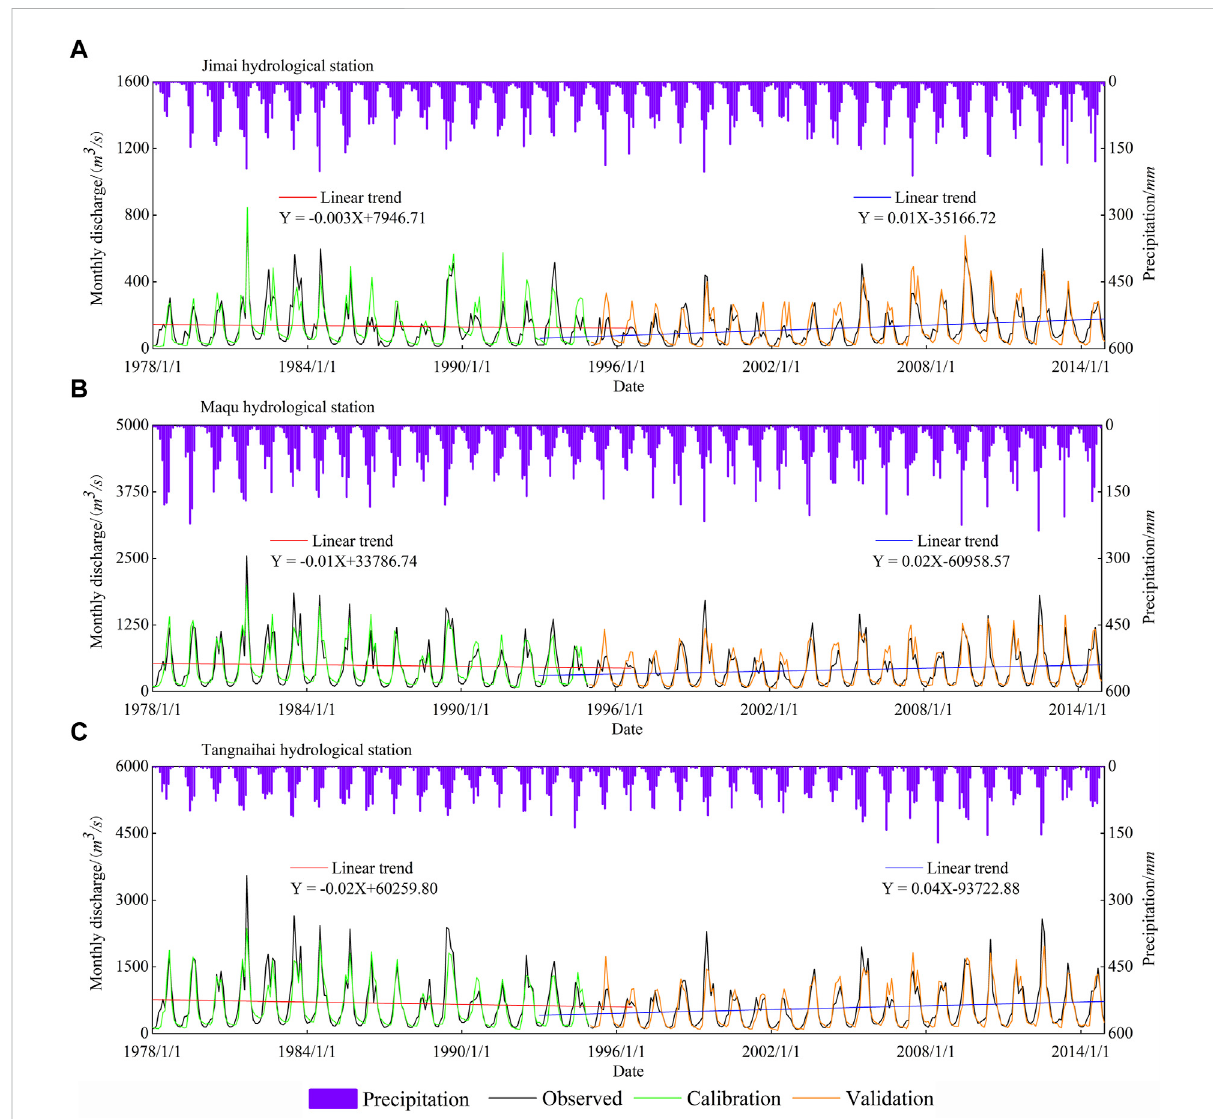
FIGURE 3 Temporal variation of the simulated and measured monthly discharge in the three hydrological stations ( (A) Jimai (B) Maqu (C) Tangnaihai) during the calibration and validation periods.